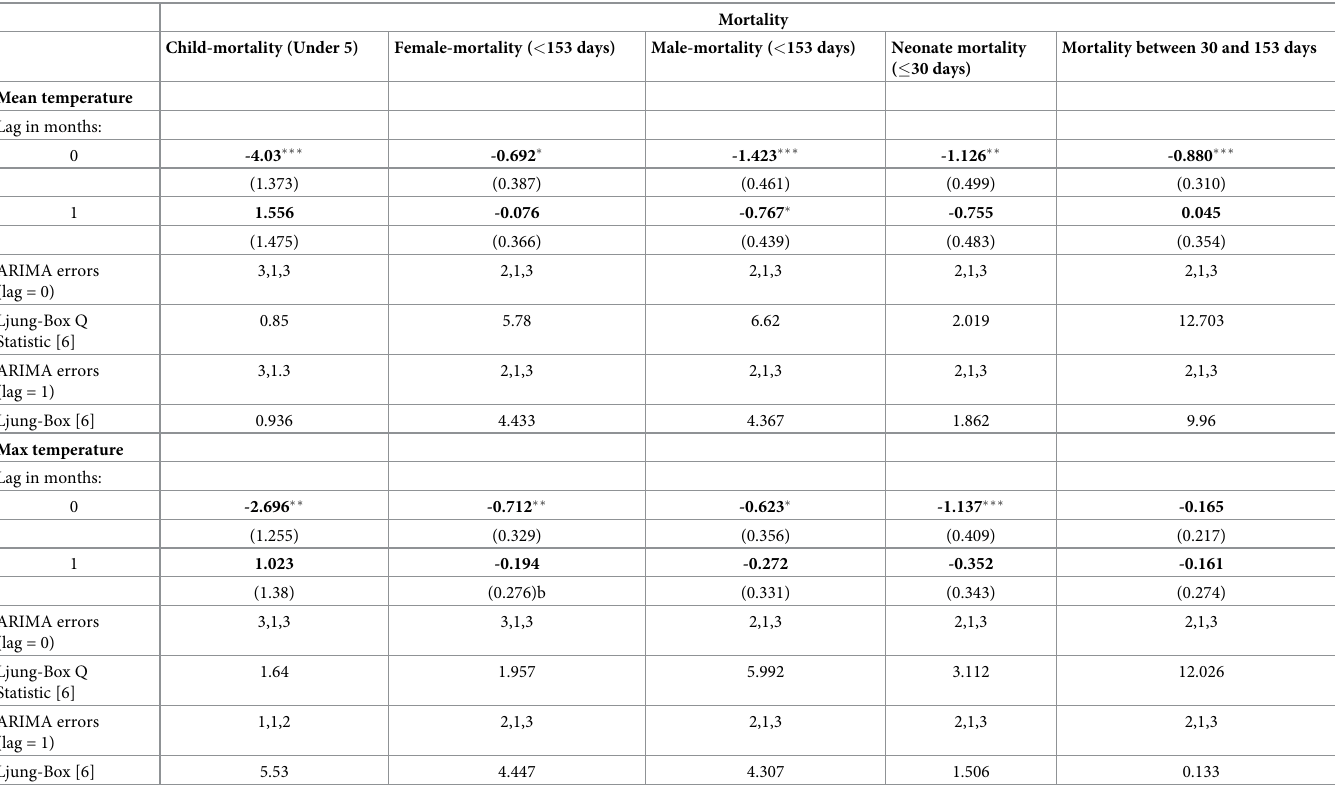
In Table 2, the values calculated for “Child-mortality (Under 5)” are incorrect. Please see the complete, correct Table 2 here. Table 2. Relationships between mortality (under 5, female and male < 153days, kids < = 30days and kids > 30 days) and monthly temperature (mean and maximum) over lags 0 to 1